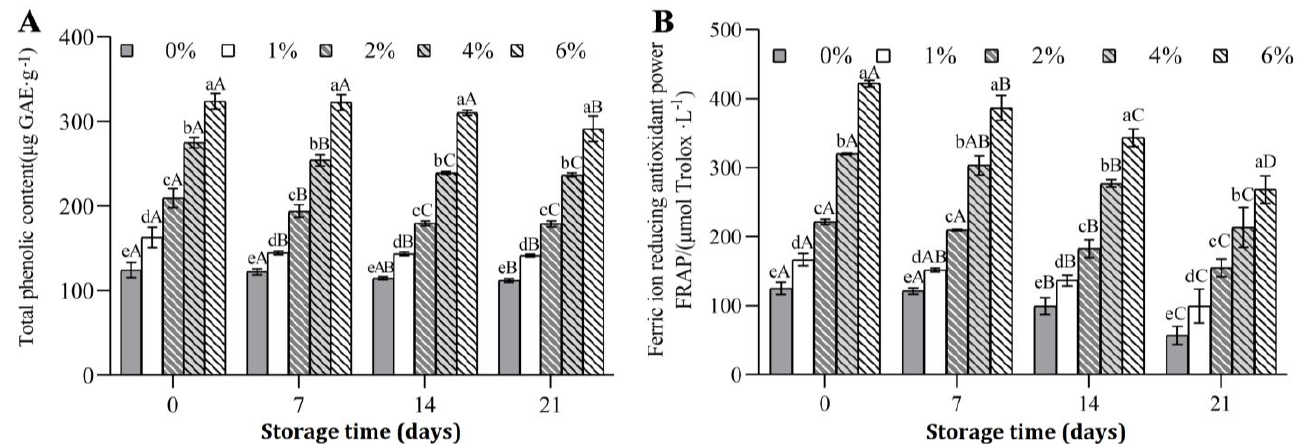
Figure 2. Total phenolic content ( A ) and antioxidant activity ( B ) of FGM supplemented with BHJ during 21 days of storage at 4 °C. Note: Different lowercase letters denote significant differences ( p < 0.05) between different concentrations of blue honeysuckle juice; different uppercase letters denote significant differences ( p < 0.05) between different storage times.